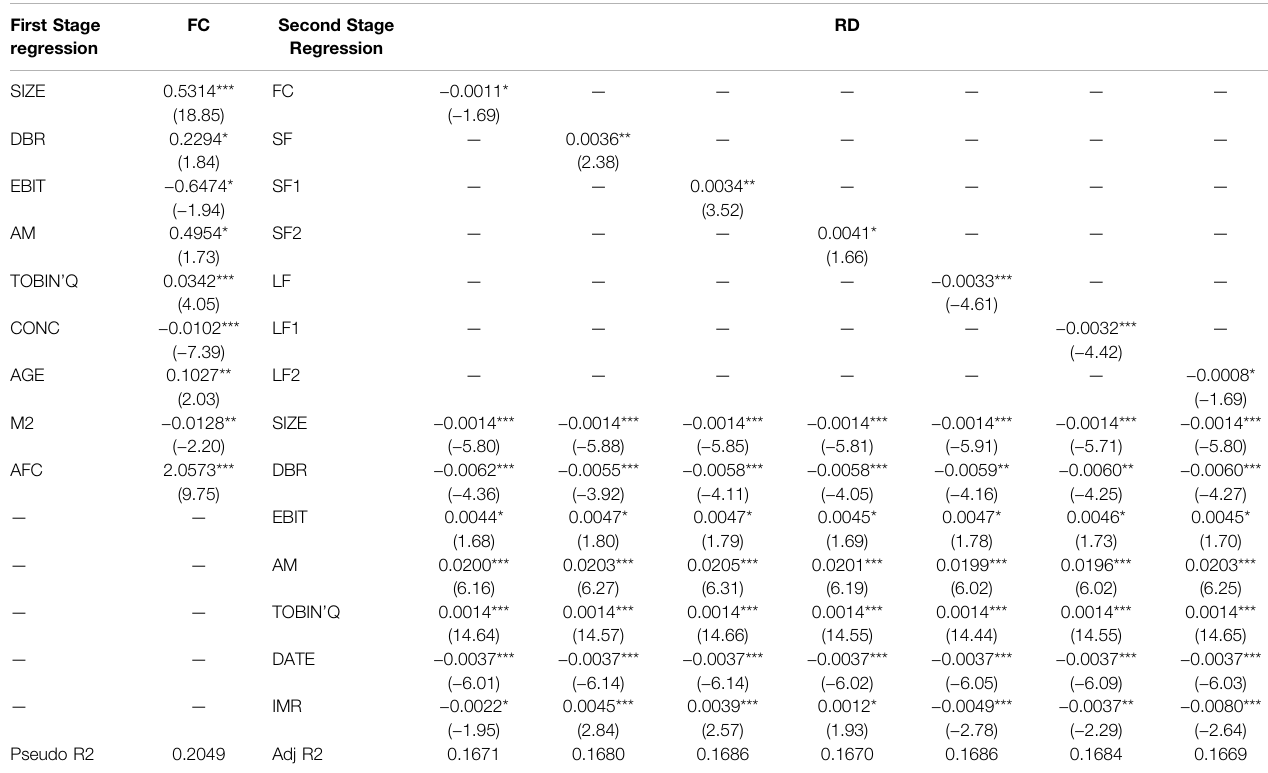
TABLE 9 | Heckman two-stage regression results.